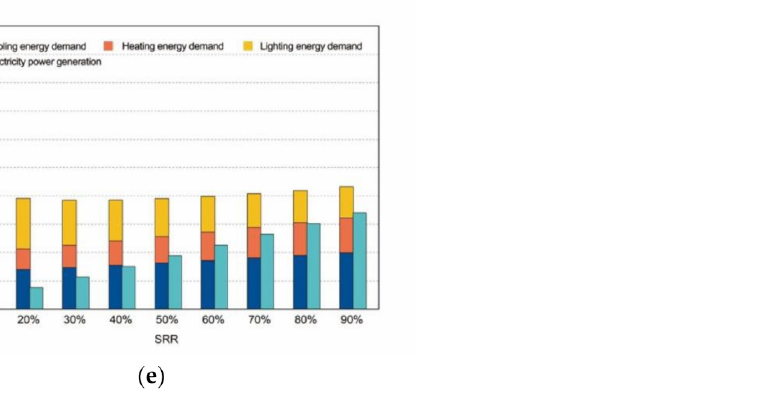
Figure 5. Energy performance of STPV skylights integrated into flat roofs. ( a ) Case 1: Lijiang; ( b ) Case 2: Hohhot; ( c ) Case 3: Beijing; ( d ) Case 4: Guangzhou; ( e ) Case 5: Chongqing.